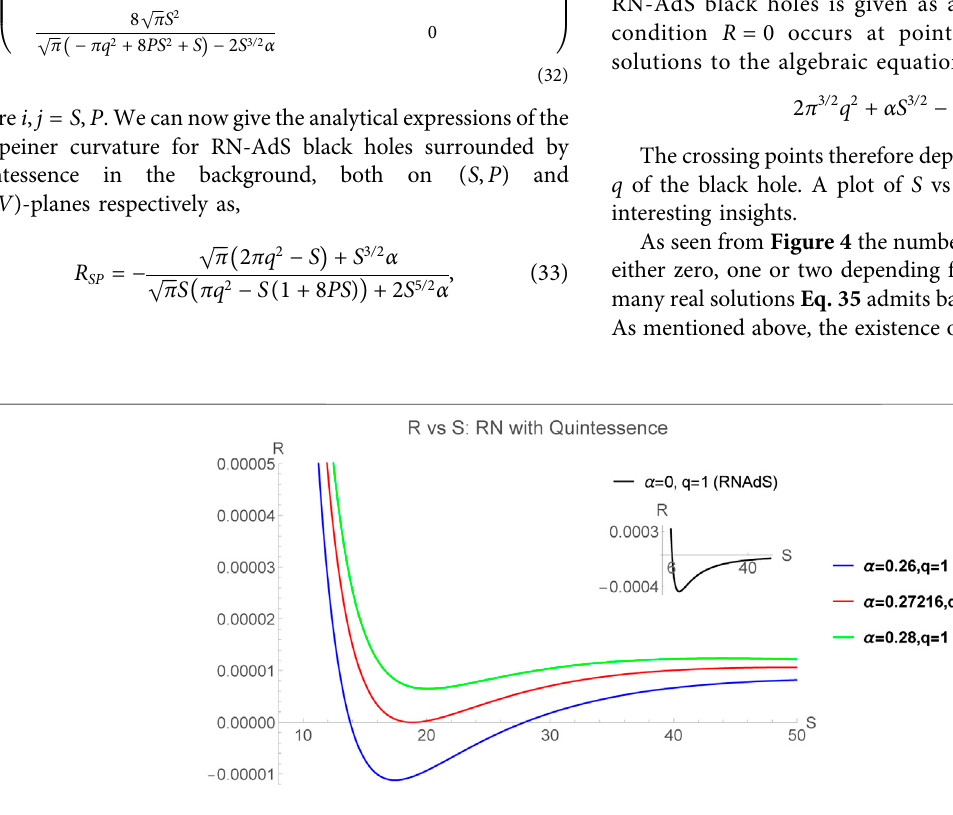
FIGURE 2 | Ruppeiner curvature on the ( S , P ) -plane as a function of S for fi xed P .